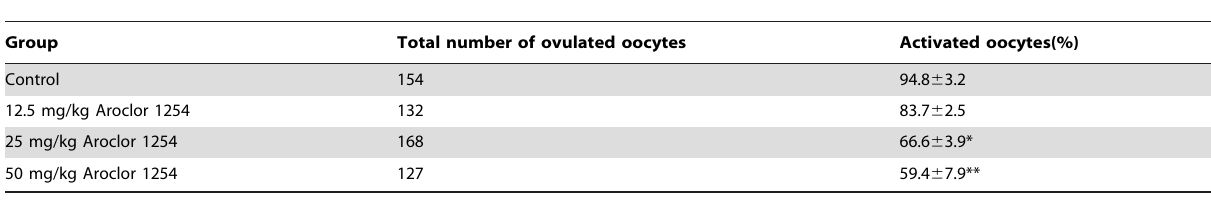
Table 1. Effect of Aroclor 1254 on the parthenogenetic activation of oocytes.